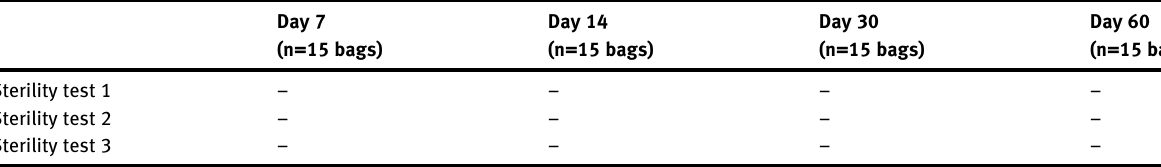
Table  : Resultsof visual inspection of bags batch produced after incubation at +  ° C for  days followed by incubation at +  ° C for 